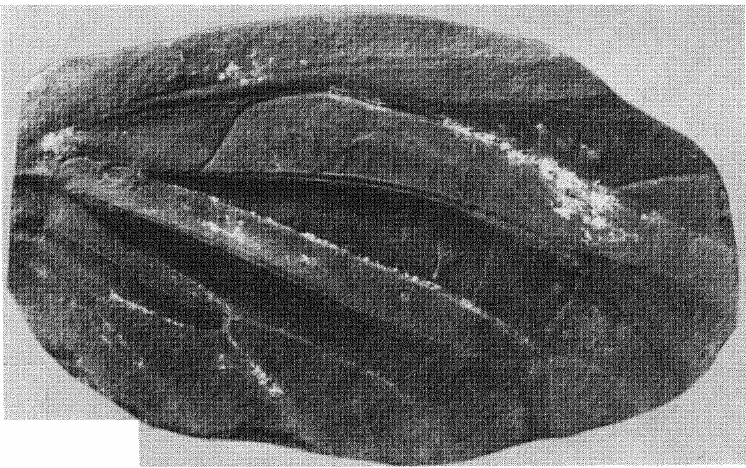
Fig. 9. Lithoneura mirifica Carpenter, hind wing. No. 299, Wolff Collection. Length of fragment, 28